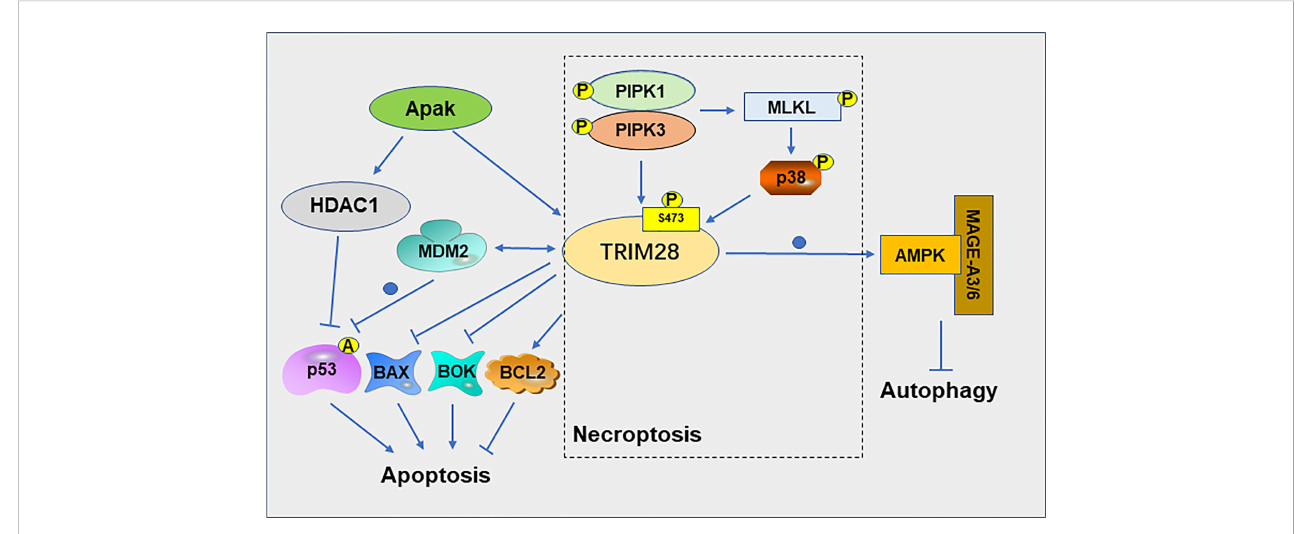
FIGURE 4 Role of TRIM28 on apoptosis, necroptosis and